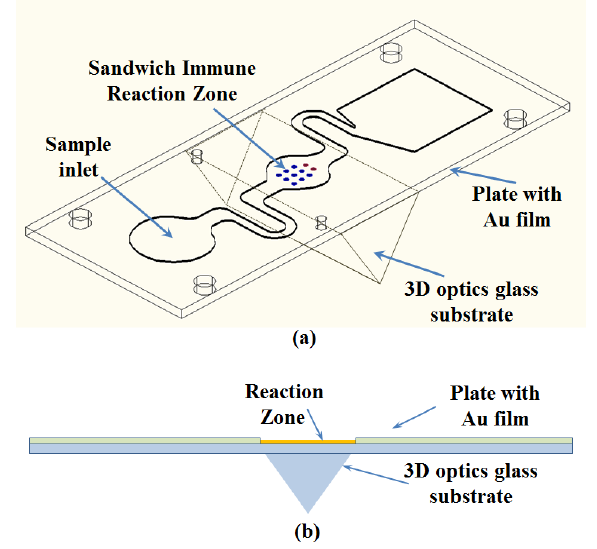
Figure 1. The design diagram of the microfluidic chip: ( a ) 3D diagram of the chip, and ( b ) front view of the chip.